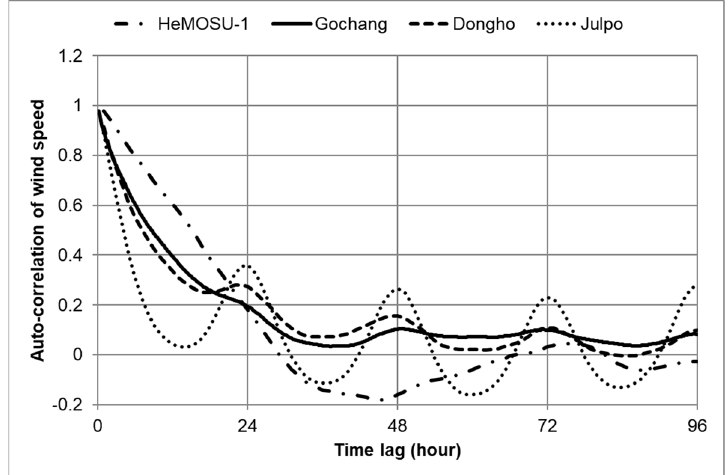
Figure 5. Auto-correlation plots of wind speed data.